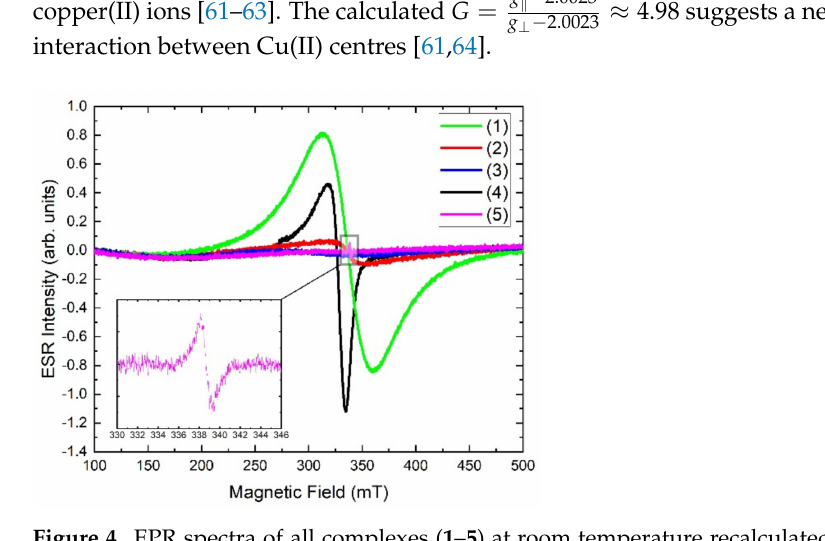
Figure 4. EPR spectra of all complexes ( 1 – 5 ) at room temperature recalculated to 9.5 GHz. Inset shows the magnification of the sharp signal for complex ( 5 ). Table 1. The g-factors obtained from EPR measurements and the line